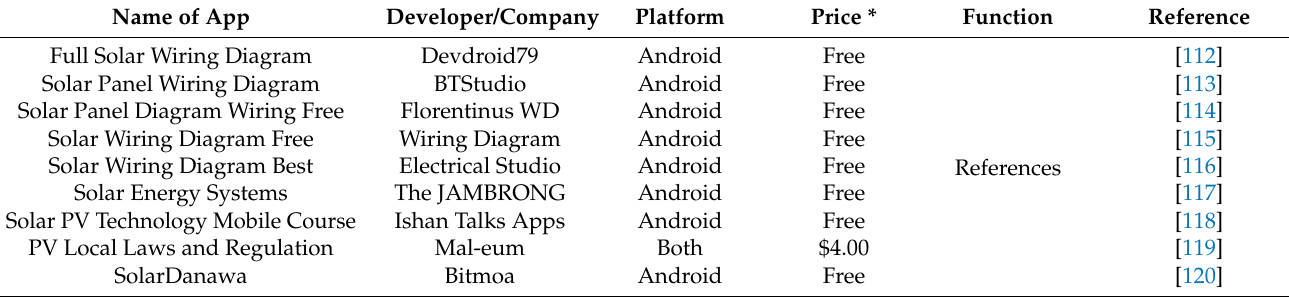
Table 9. Summary of smartphone applications for education and learning purposes of PV